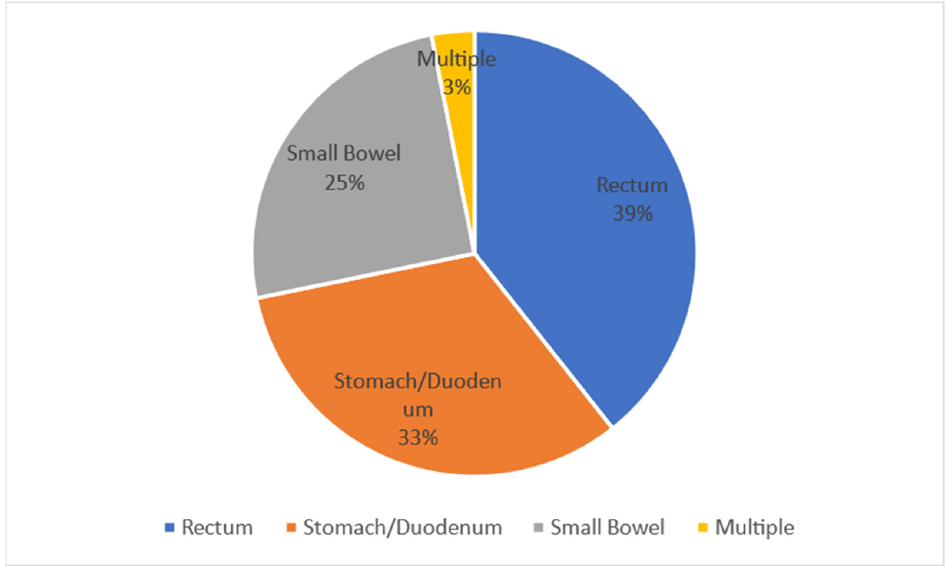
anatomical site.